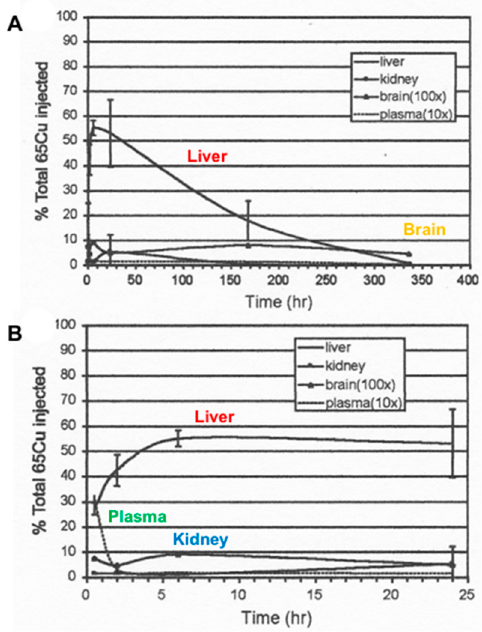
Figure 1. Time course of loss ( A ) and incorporation ( B ) of excess extrinsic 65 Cu from mouse organs after the injection of this stable isotope. Mice were preloaded with 3 times more Cu than the total estimated to be in their bodies, over 14 h, after which they were sacrificed at various times, as indicated, and the percent dose was determined. Data for plasma and brain were multiplied 10 × and 100 × , respectively, to make them visible. Annotated, and reprinted with permission from Springer, Biometals, Copper binding components of blood plasma and organs and their response to influx of Table 1. Copper in Fluids of the Human Gastrointestinal Tract and Urine*.